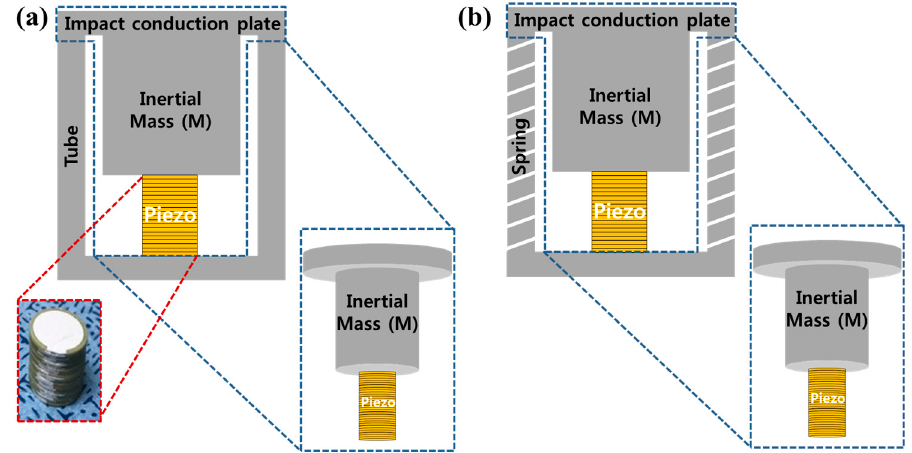
Figure 6. Schematic diagram and a photograph of the piezoelectric energy harvesting systems based on a shock absorber without a spring structure ( a ) and with a spring structure ( b ).